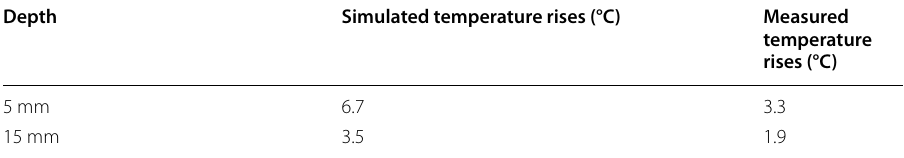
Table 2 Temperature rises after 15 min of heating Depth Simulated temperature rises (°C) Measured